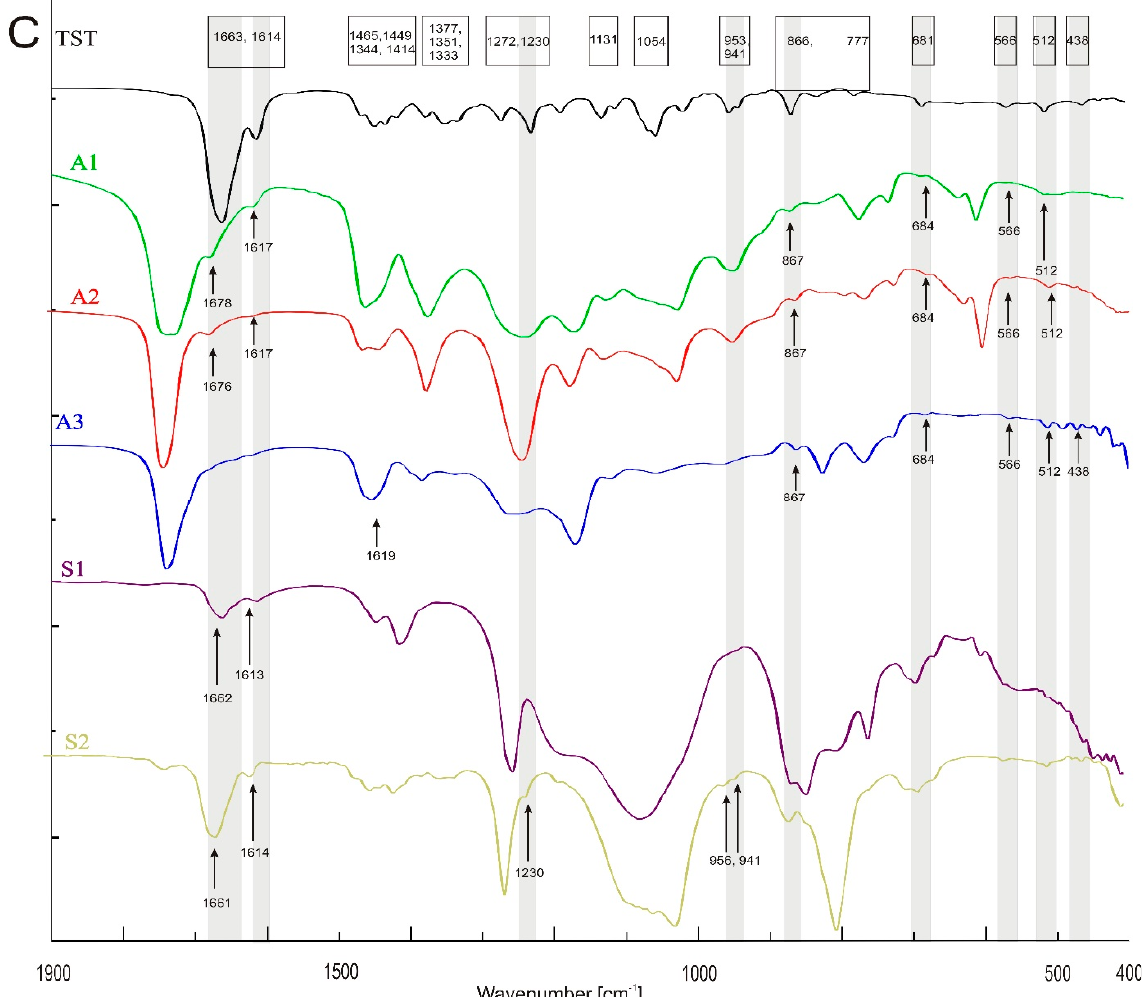
Figure 2. FTIR spectra of polymeric patches with API: ( A ) indomethacin, ( B ) cytisine, ( C ) testosterone.